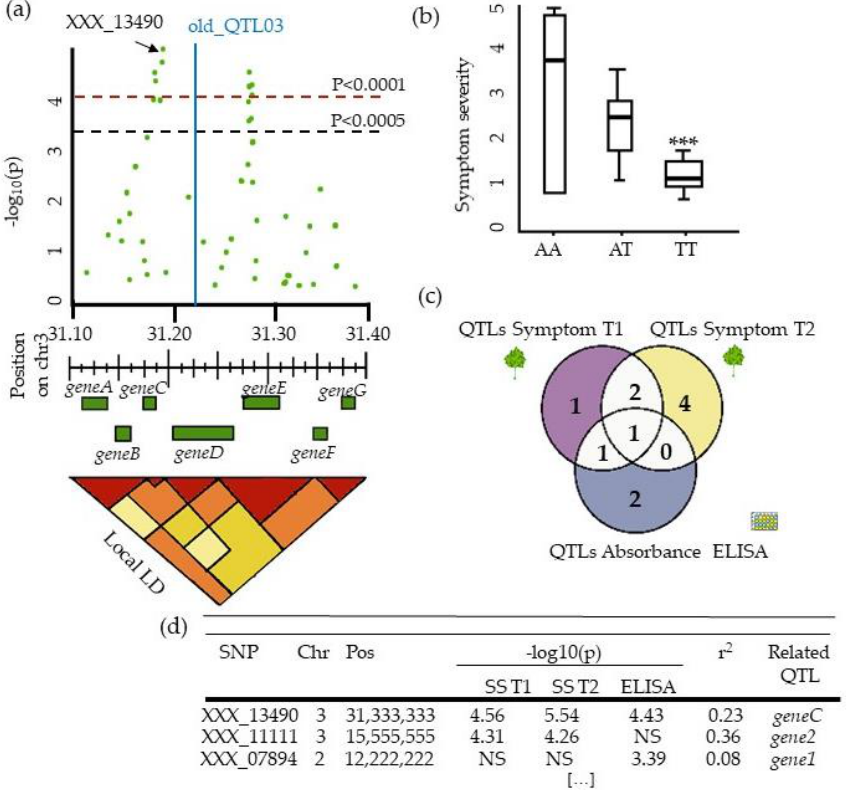
Figure 8. Overview of the main figures of a fictitious post-GWAS pipeline following the pre-GWAS and GWAS presented in Figure 3 and Figure 7 ( a ) Regional plot of SS T1 zoomed on the QTL in the end of chromosome 3 and colocating with ELISA absorbance peak. The most significant SNP is XXX_13490colocalizing with the historical old_QTL3 that was mapped with RILs. The geneC is the single gene in its local linkage disequilibrium bloc. ( b ) Analysis of the effect of the XXX_13490 alleles of SS T1, TT genotypes are significantly more resistant than AA and AT genotypes ( c ) Venn diagram showing the number of unique and shared QTLs between SS T1, SS T2, and ELISA absorbance T1. ( d ) Effect of significant genes detected using GWAS for the three traits.